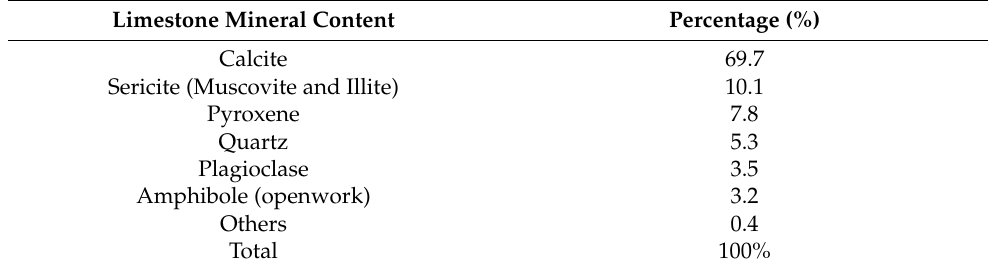
Table 2. Mineral content of Okcheondae